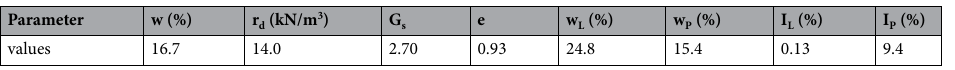
Table 1. Main physical properties of loess from Xining. w Water content, rd Dry unit weight, Gs Specific gravity, e void, wL Liquidity limit, wP Plastic limit, IL Liquid index, IP Plasticity index.